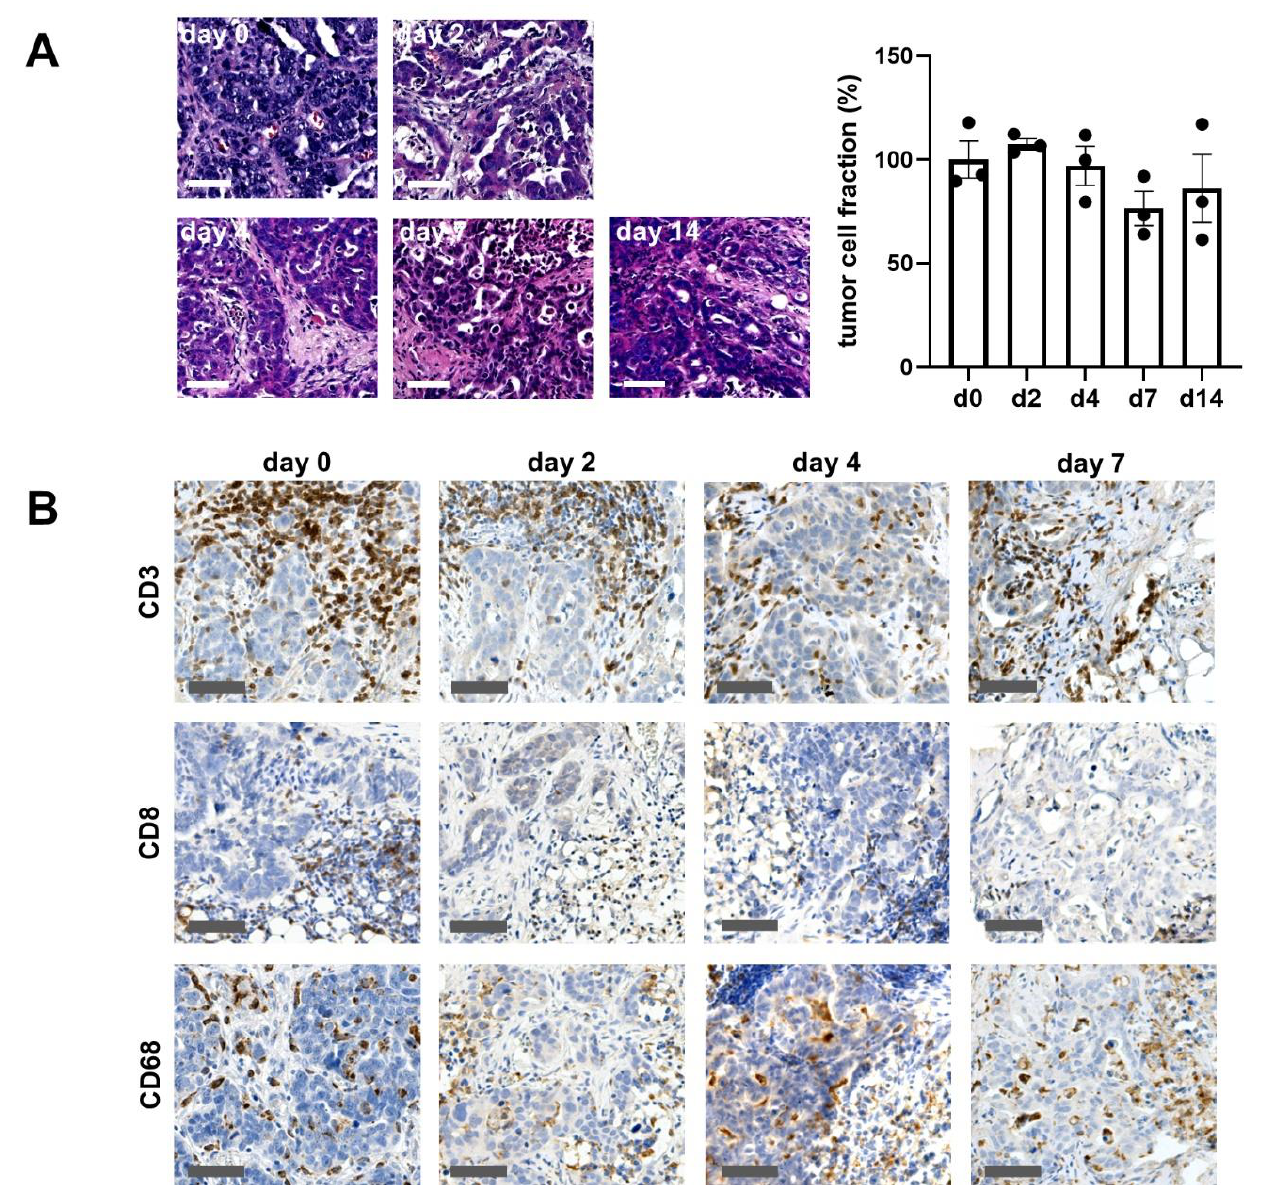
Figure 1. Tissue preservation ex vivo. ( A ) Tissue culture maintains its architecture and cellular composition throughout the cultivation period of 14 days. Tissue was fixated at the indicated days, embedded in paraffin and stained with H&E. Here, tissue was cut horizontally, 5 µm thick. Bar = 100 µM. The tumor fraction was stable up to day 14. Each dot represents one specimen ( n = 3), d = day. Day 0 was set to 100%. Error bars show SEM ( B ) Tissues were stained with antibodies against CD3, CD8 and CD68 on day 2, 4 and 7 and were compared to day 0. Bar = 100 μm. ( n = 3). One-way ANOVA ( p < 0.05) showed no significant alterations.